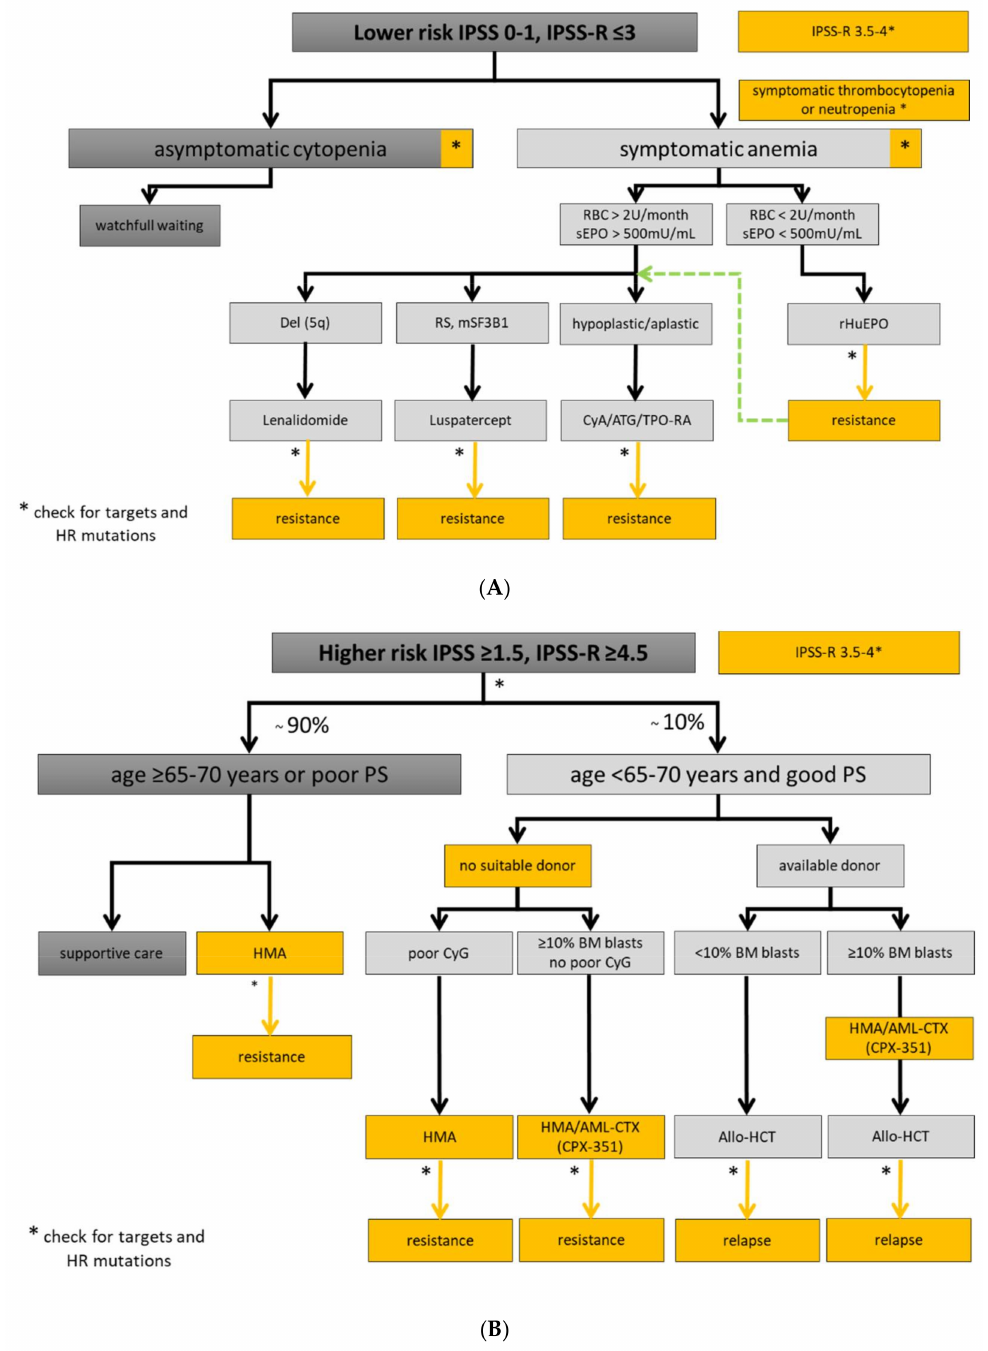
Figure 3. Treatment algorithm for lower- and higher-risk MDS. Yellow boxes highlight areas with an unmet clinical need in in lower ( A ) and higher-risk MDS ( B ). High-risk (HR) mutations comprise: ≥ 3 SLADMs or single mutations in TP53 , RUNX1 , ASXL1 , ETV6 , EZH2 , SRSF2 , U2AF1 , RAS -pathway and JAK2 with VAF ≥ 2% [13,74,75]. Allo-HCT: allogeneic hematopoietic stem cell transplantation; AML-CTX: AML-based chemotherapy; ATG: antithymocyte globulin; BM: bone marrow; CSA: Cyclosporine A; CyG: cytogenetics; ESA: erythropoietin stimulating agent; HMA: hypomethylating agent; HR: high-risk mutations; mSF3B1 : mutated SF3B1 ; PB: peripheral blood; PS: performance status; RBC: red blood cell concentrate; RS: ring sideroblasts; sEpo: serum erythropoietin; TPO-RA: thrombopoietin receptor agonist. Adapted from